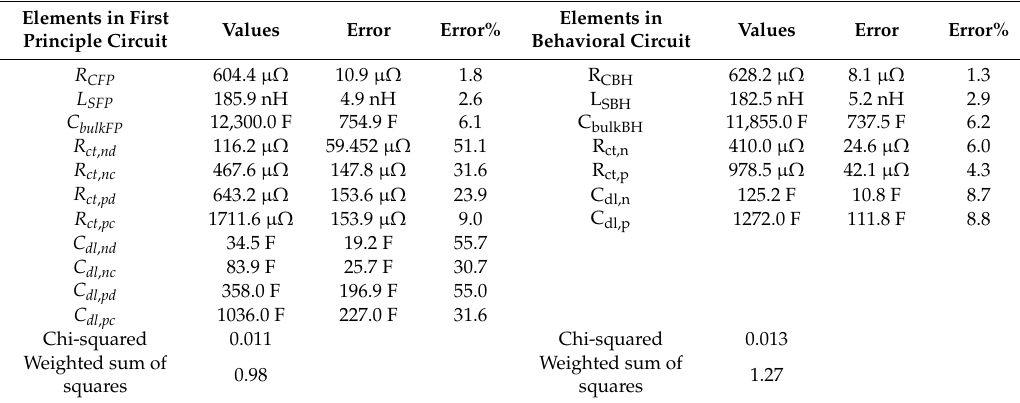
Table 2. Values of elements in FPLC ACequ and BHLC ACequ for E-08#.